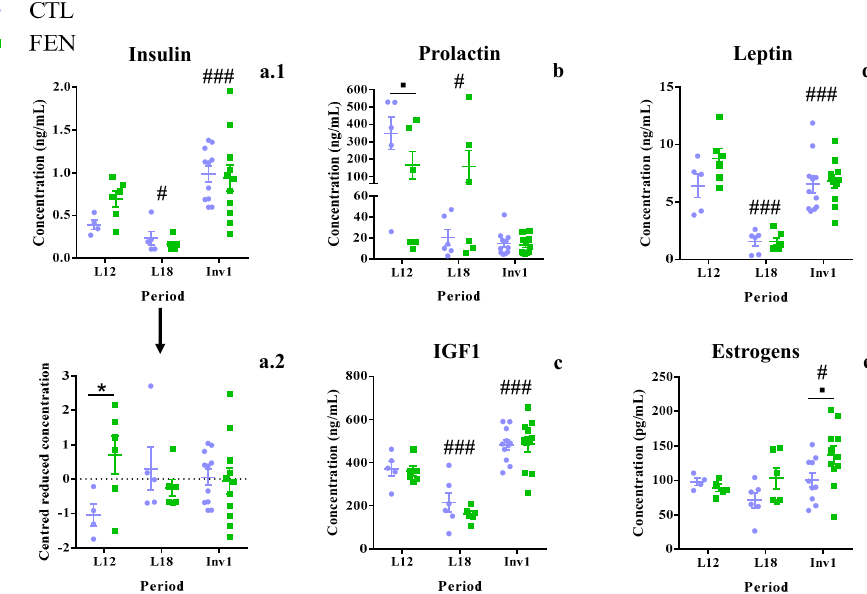
Figure 3. E ff ect of fenugreek on the concentration of insulin ( a.1 , a.2 ), prolactin ( b ), IGF-1 ( c ), leptin ( d ) and estrogens ( e ) in maternal plasma along the lactation period. Figure 3a.2 represents insulin concentration centered and reduced by period. Values are mean ± SEM with n = 4–6 at L12 and L18 and n = 11 at Inv1. Data were analyzed with 2-way ANOVA followed by Sidak’s post-hoc test for diet effect and Tukey’s post-hoc test for period effect: p < 0.1 and *: p < 0.05 for diet comparison; #: p < 0.05, and ###: p < 0.001 for comparison between a given period and the immediately preceding period.